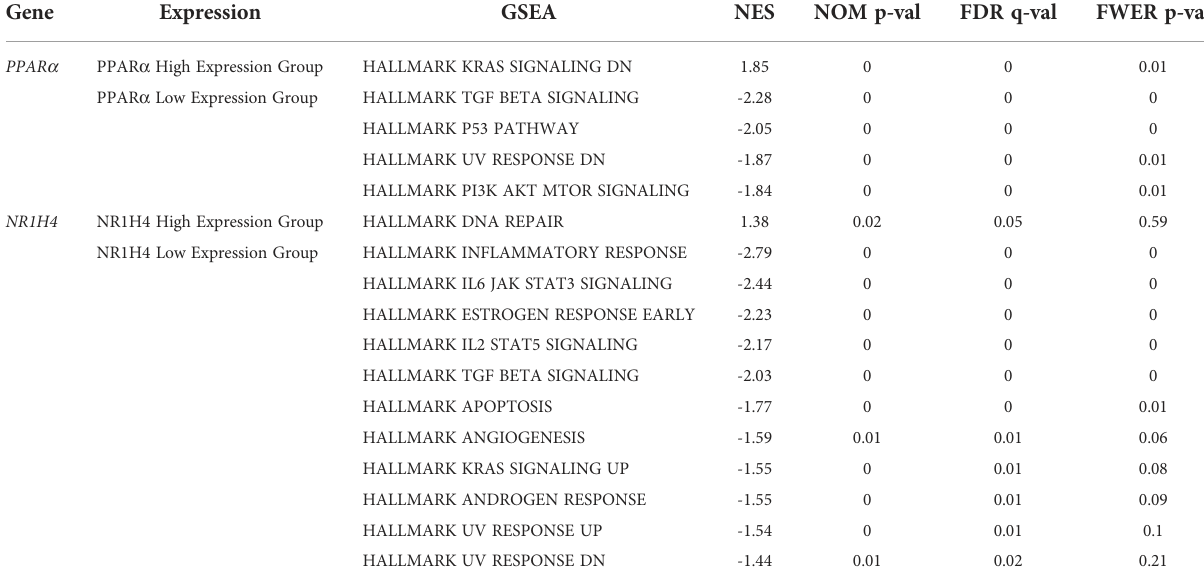
TABLE 2 GSEA enrichment analysis results for high and low expression of PPAR a and NR1H4 in BA patients, and GSEA results excluding patients with hepatitis B, normal liver, liver cancer, and non-BA cholestasis.